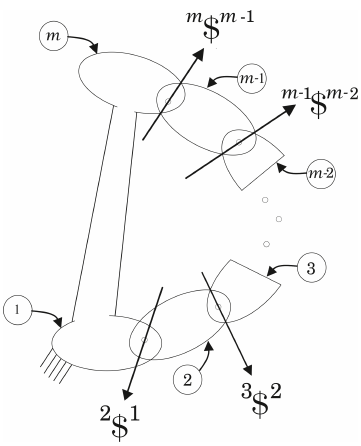
Figure 1. Single-loop closed chain.